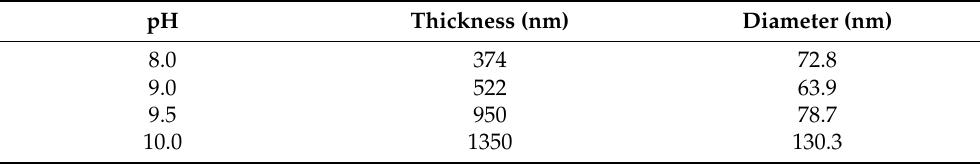
Table 3. Enhancement calculation for the different noble metal substrate.